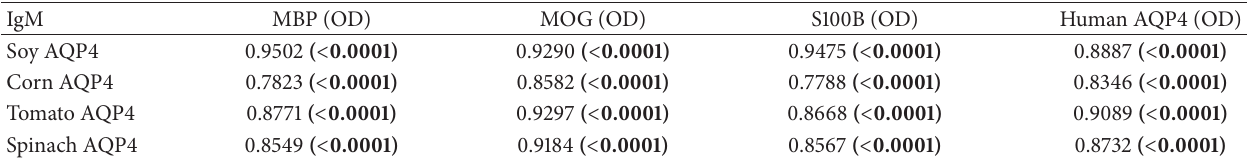
Table 4: Results of the simple linear regression between each pair of lgM isotypes of the food proteins and brain proteins in MS patients. The first number in each cell presents corresponding Pearson’s correlation coefficient and the second number in parentheses presents its 𝑝 value. Small 𝑝 values (less than 0.05) are marked in bold. Note that 𝑅 2 values of these regressions are the squares of Pearson’s correlation